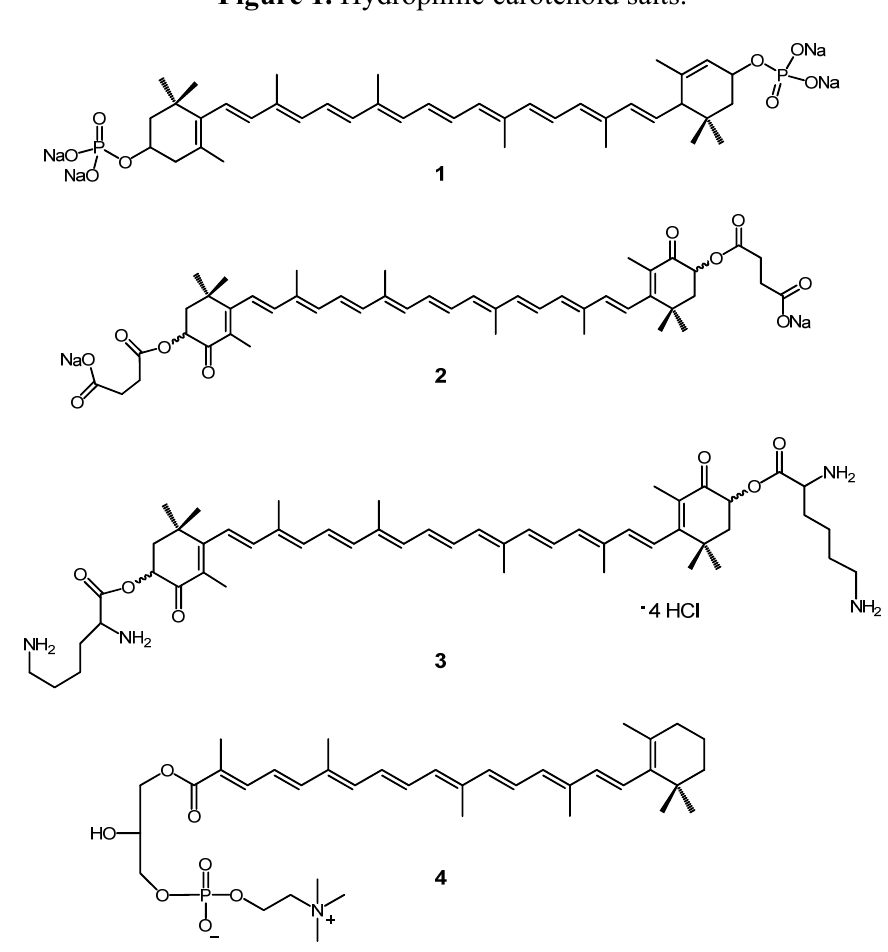
Figure 1. Hydrophilic carotenoid